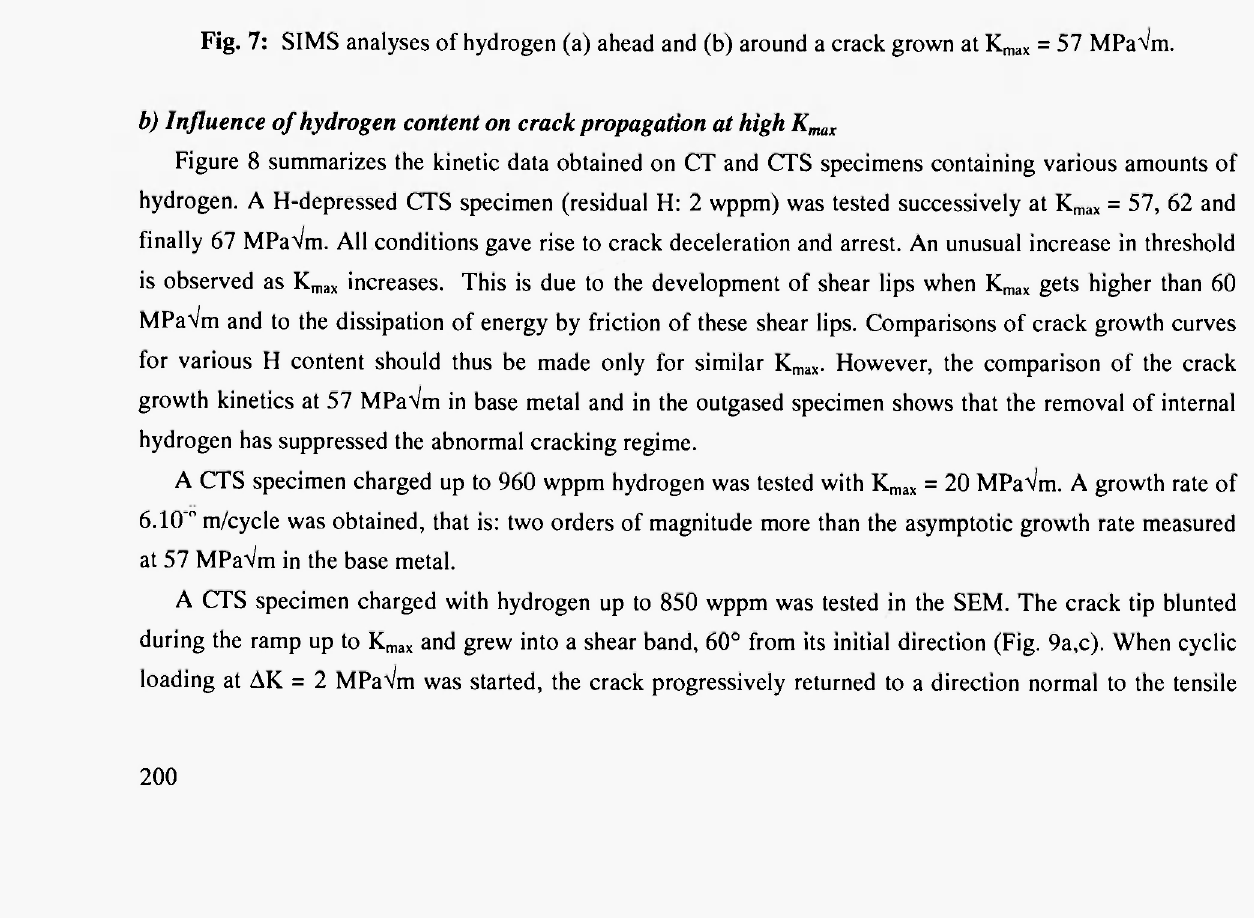
Fig. 7: SIMS analyses of hydrogen (a) ahead and (b) around a crack grown at K max = 57